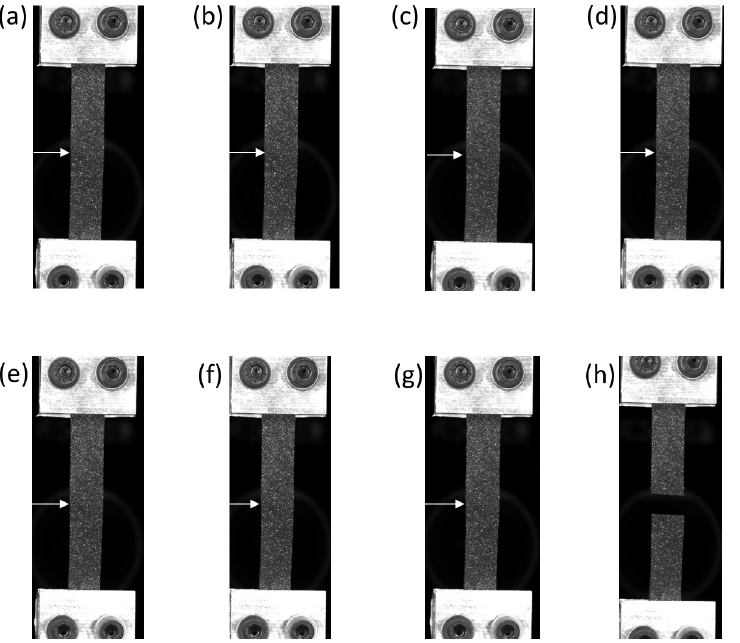
Figure 5. Pictures related to Figure 4, specimens overmoulded at 190 ◦ C. TPV1 is at the bottom and TPV2 at the